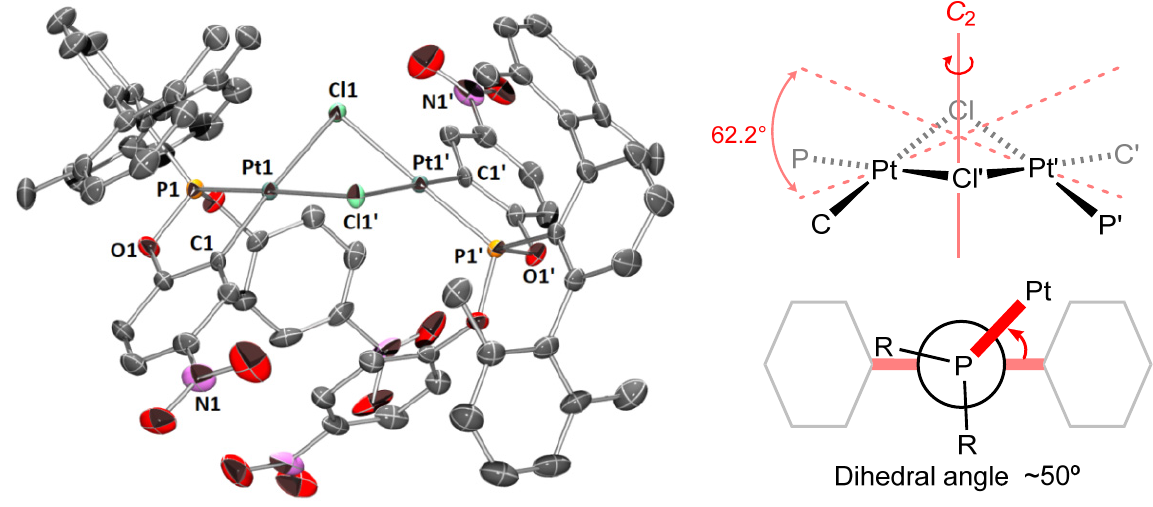
Figure 4. ORTEP view of the X-ray molecular structure of complex 2 , with ellipsoids at the 50% probability level and H atoms omitted for clarity ( left ); schematic view of the coordination planes in 2 with the angle they form and the binary axis C 2 (top right ); schematic view of the B conformation adopted by the ligand PAr Xyl 2 (OPh NO 2 ) 2 (bottom right) [18,26]. Selected bond distances (Å) and angles (°): Pt1-P1 2.146(1), Pt1-C1 1.974(4), Pt1-Cl1 2.410(1), Pt1-Cl1 ′ 2.398(1); P1-Pt1-C1 82.6(1); C1-Pt1-Cl1 ′ 95.4(1); Cl-Pt1-Cl’ 82.89(4); Cl1-Pt1-P1 99.10(4); Pt1-Cl1-Pt1 ′ 82.60(4).